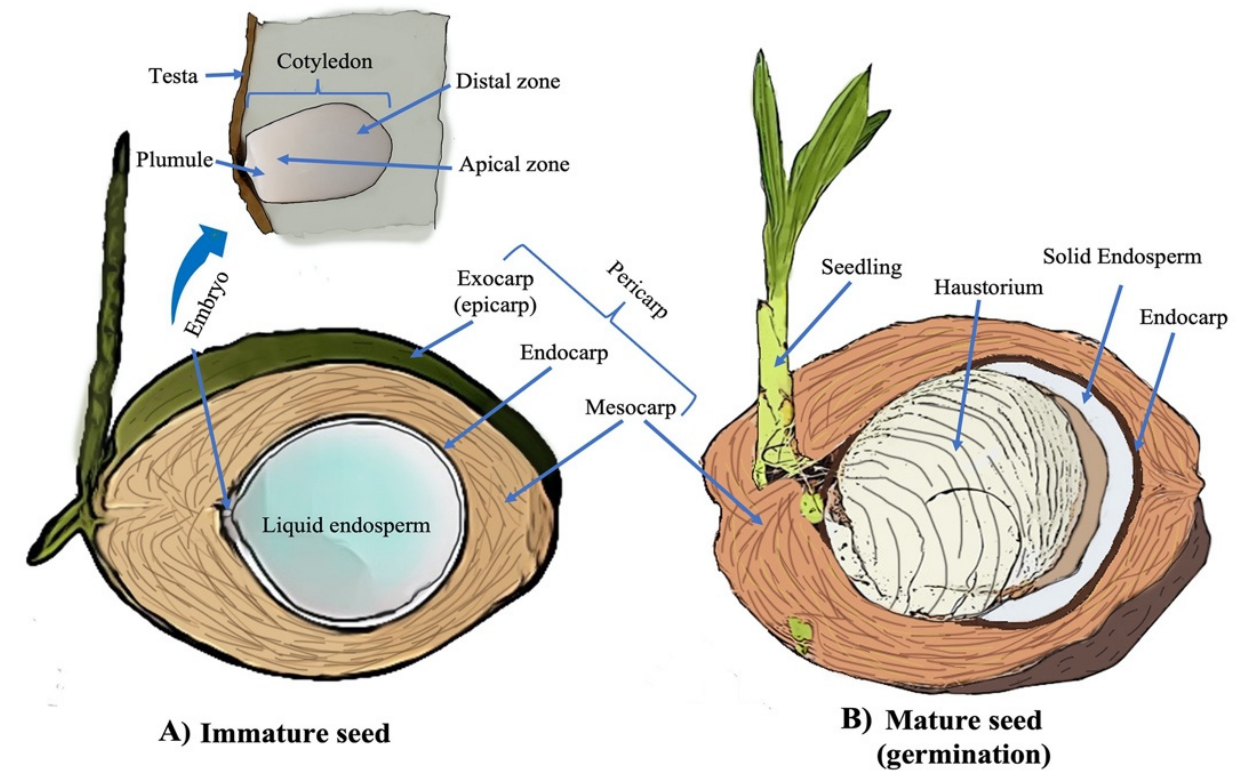
Figure 1. Structure of the coconut fruit and its components. ( A ) longitudinal section of the immature fruit; above, close-up of the embryo and ( B ) longitudinal section of the mature fruit in the process of germination.